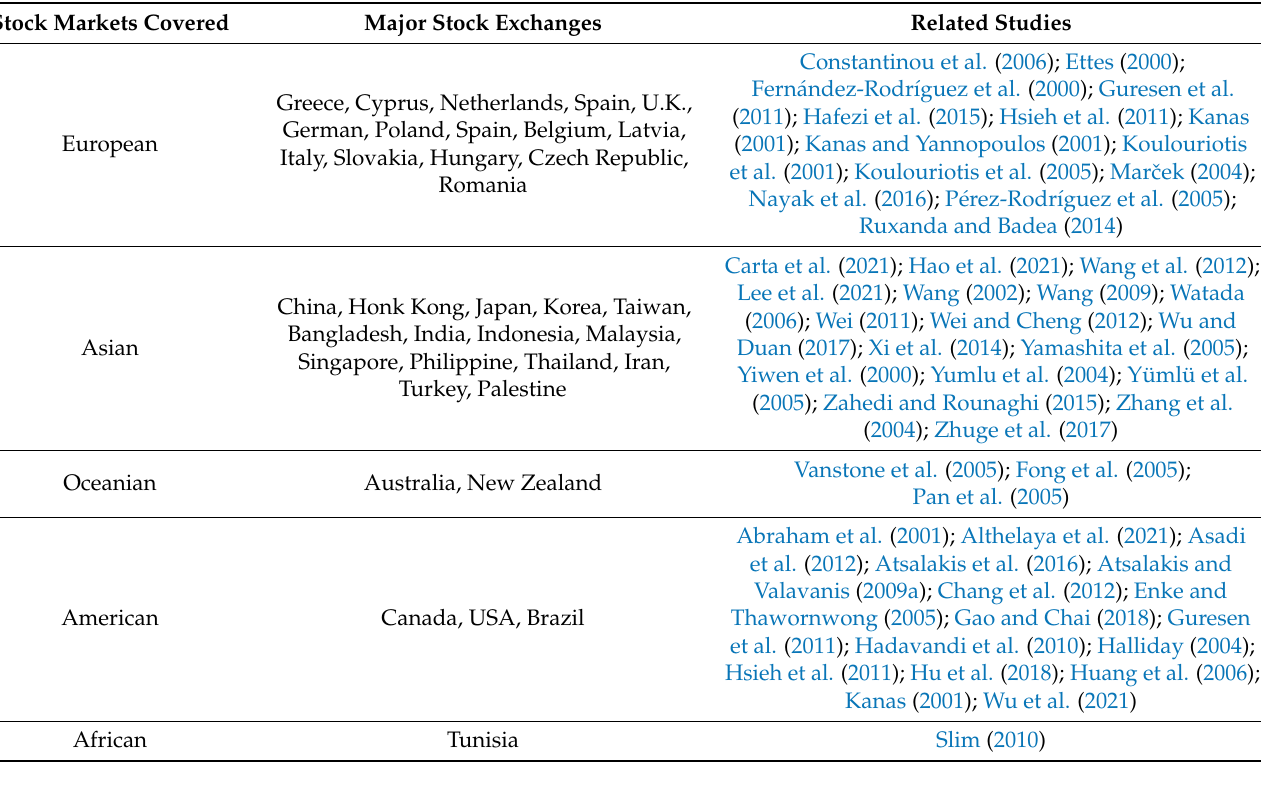
Table A1. Stock markets covered.